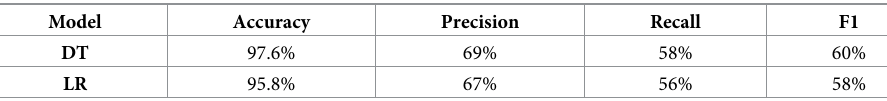
Table 7. Results of training under poisoned data.